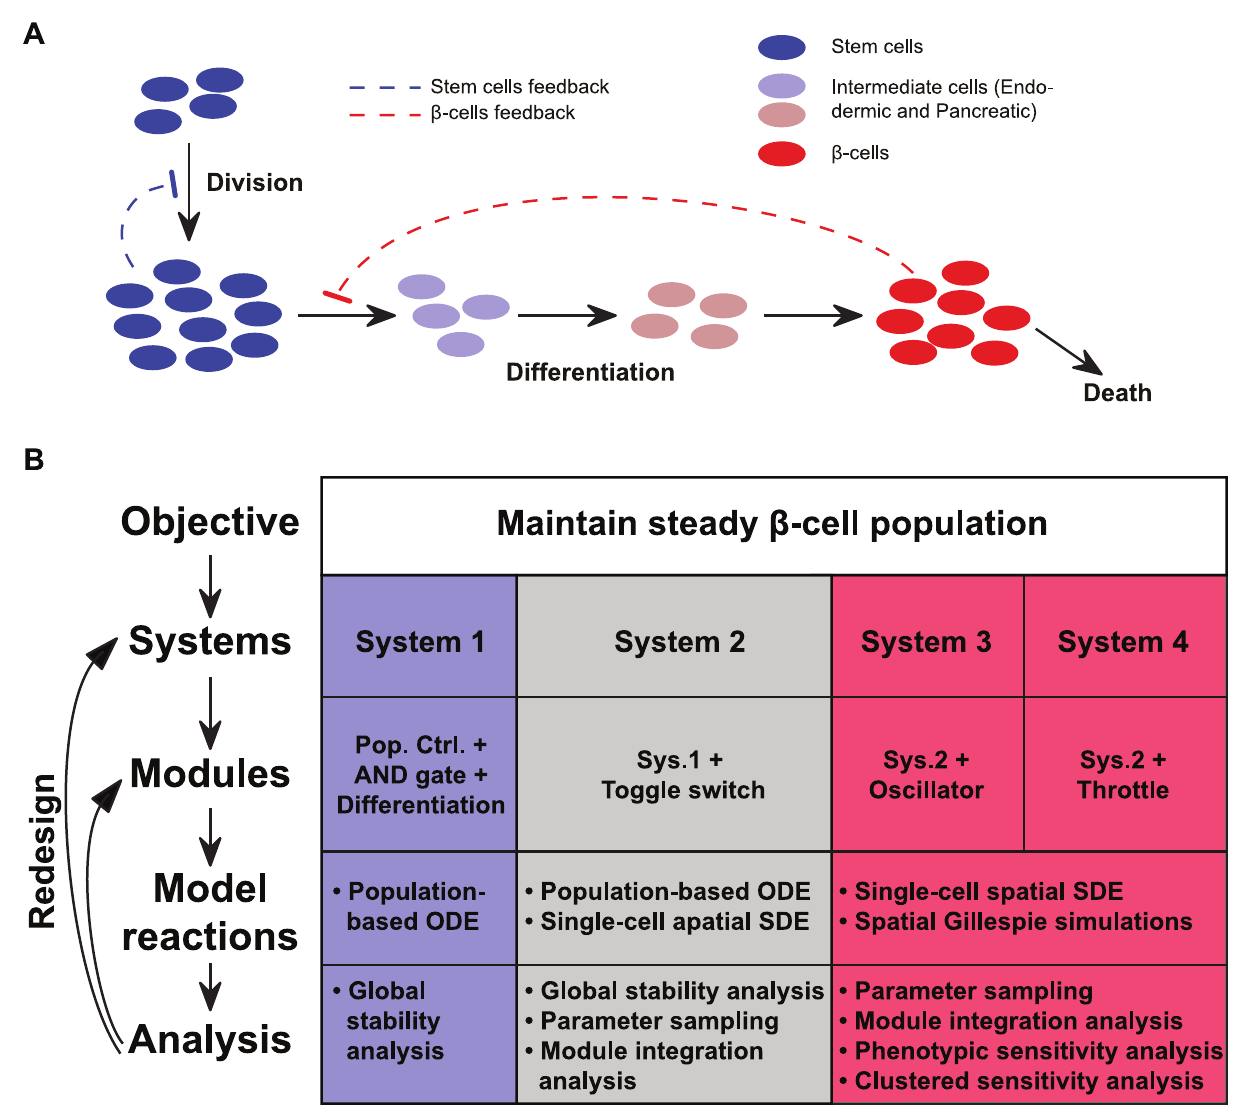
Figure 1. Overview of system design. (A) The general tissue homeostasis design. Proliferation of stem cells (blue) is regulated by their population size through negative feedback (dashed blue line). Sequential differentiation into endodermic, pancreatic, and finally b -cells (red) occurs when the stem cell population has sufficient size, and is governed through negative feedback from differentiated cells (dashed red line). (B) Design workflow. Starting with a high-level objective, iterative design proceeds through a top-down decomposition into modules and then basic reactions of the system, followed by analysis and redesign (left). The table columns (right) show the four iterations of system designs presented in this work. Table rows describe the top-down decomposition for each system, and correspond to the workflow at